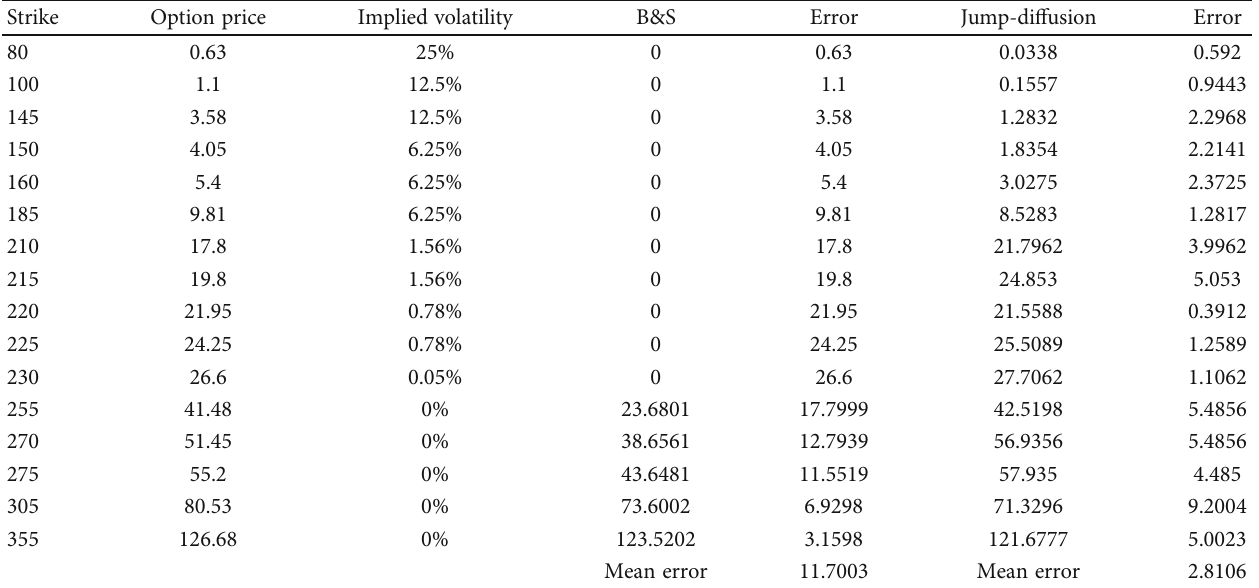
= 231 : 02 , expired on 18/03/2021 ( r = 4 % ) (from https://fr. fi nance.yahoo 0